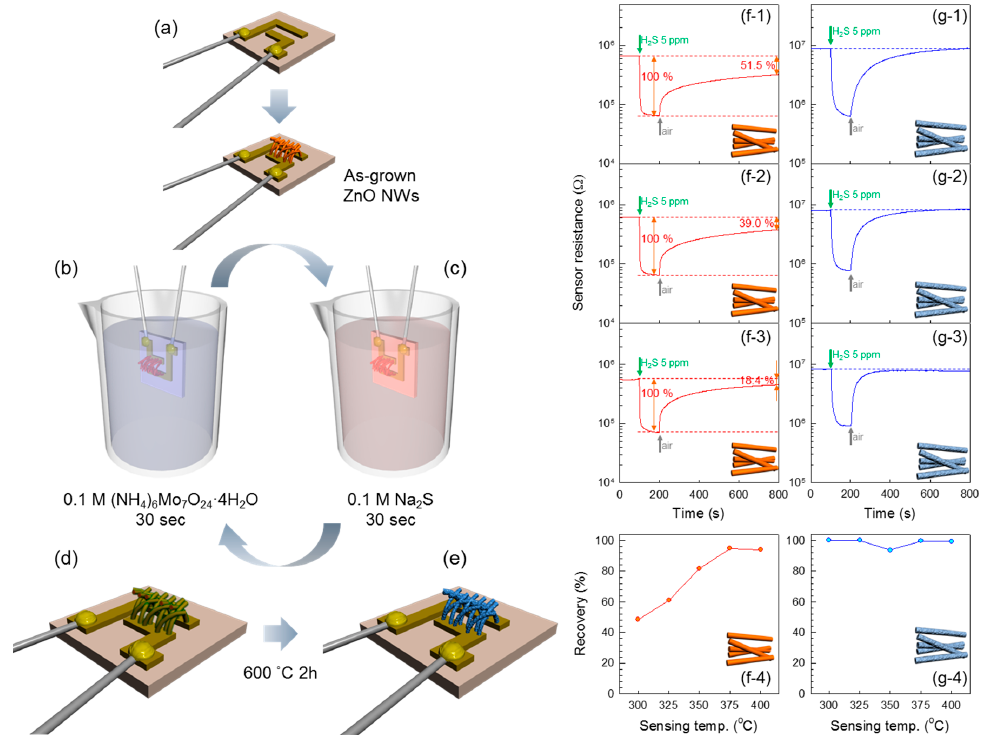
Figure 5. ( a – e ) Schematic illustration of the synthesis process of Mo-doped ZnO NW network gas sensors. Sensing transients of pure and Mo-doped ZnO NW network gas sensors to 5 ppm H 2 S at 300, 325, and 350 ◦ C: ( f-1 ) ZnO NW sensor, 300 ◦ C; ( f-2 ) ZnO NW sensor, 325 ◦ C; ( f-3 ) ZnO NW sensor, 350 ◦ C; ( g-1 ) Mo-doped ZnO NW sensor, 300 ◦ C; ( g-2 ) Mo-doped ZnO NW sensor, 325 ◦ C; and ( g-3 ) Mo-doped ZnO NW sensor, 350 ◦ C; ( f-4 , g-4 ) Recovery (%) = (R air-recovery − R gas-H2S )/(R air-fresh − R gas-H2S ) × 100 (%) of pure and Mo-doped ZnO NW sensors at 300–400 ◦ C (where, R air-fresh : sensor resistance in air before exposure to H 2 S, R gas-H2S : sensor resistance in 5 ppm H 2 S, and R air-recovery : sensor resistance in air after 10 min exposure to air). Reproduced from [88] with permission. Copyright (2014) The Royal Society of